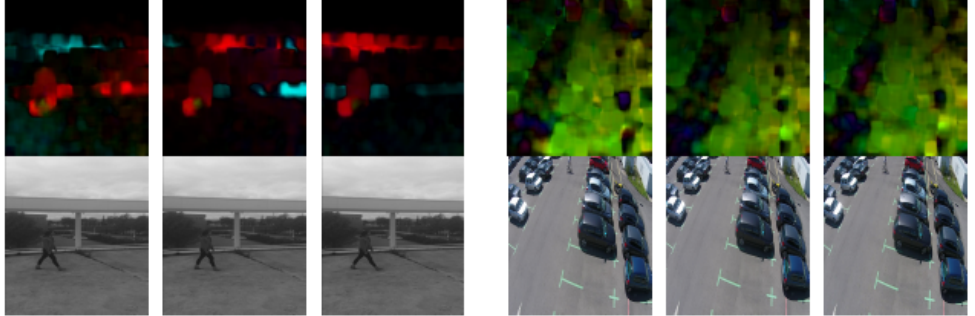
Figure 3. Optical flow samples of MDVD and other